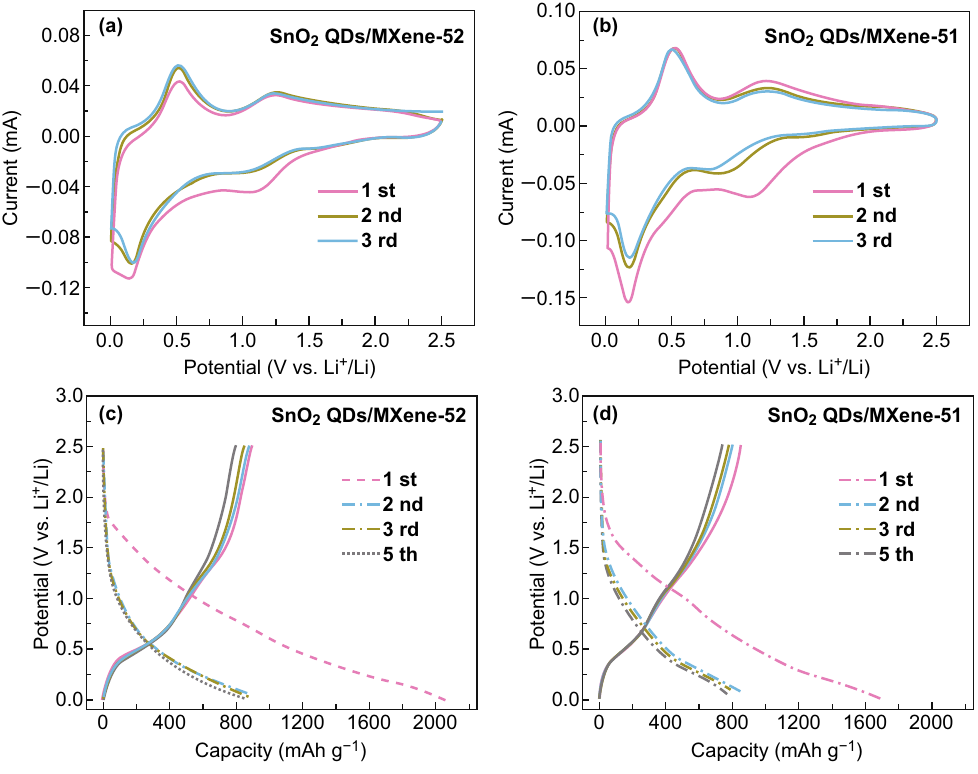
Fig. 4 Electrochemical performances as anode in LIBs. a , b CV curves of SnO 2 QDs/MXene at a scan rate of 0.1 mV s −1 in 0.01–2.5 V. c , d Charge/discharge curves of SnO 2 QDs/MXene at 50 mA g